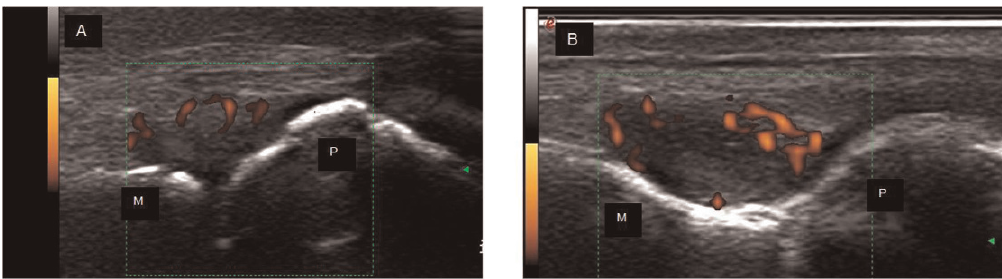
Figure 1 - Dorsal longitudinal image of 2 nd MCP; (A) Patient in group without pain with synovial hypertrophy and positive PD signal; (B) Patient in Painful group with synovial hypertrophy and positive PD signal; M=metacarpal; P=phalange.